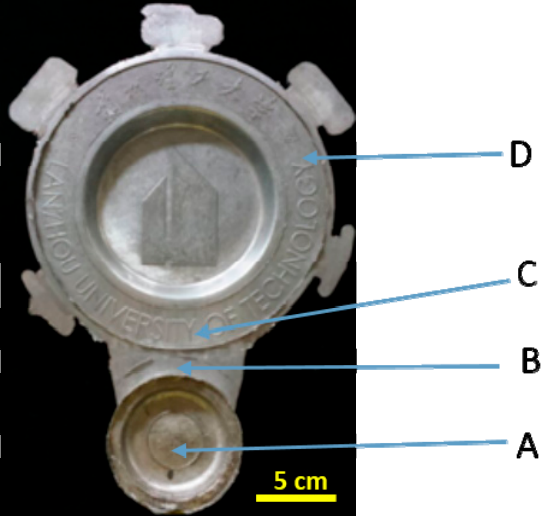
Figure 2. Product of semi-solid die casting and the sampling positions: biscuit ( A ); in-gate ( B ); down ( C ) and middle ( D ).